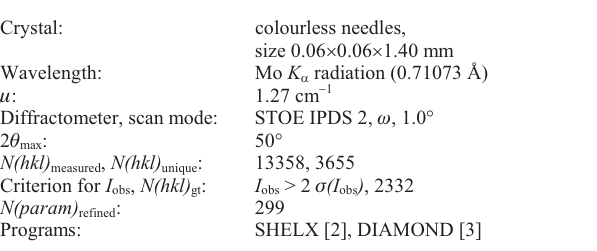
Table 1. Data collection and handling.